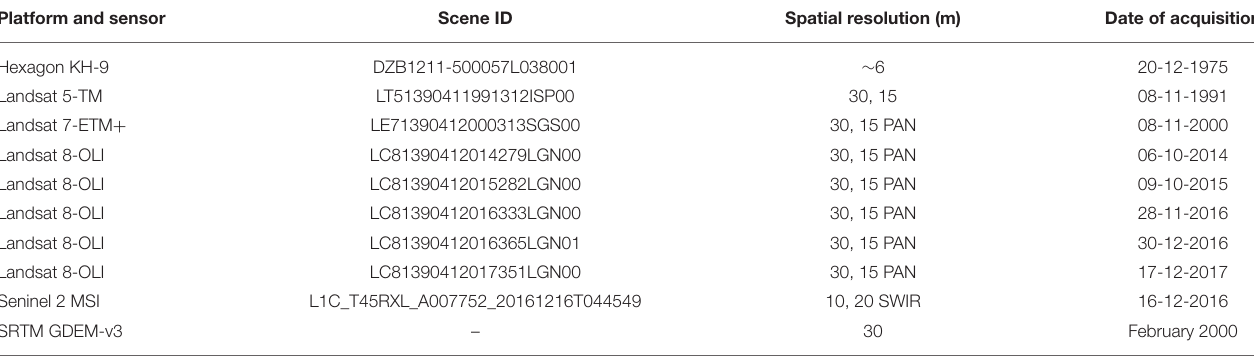
TABLE 1 | List of satellite data used in the study area (i.e., Sikkim). Platform and sensor